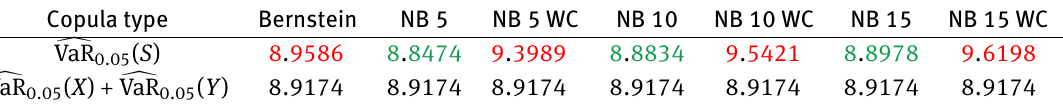
Table 2: Estimates based on Monte Carlo simulations. Bernstein and negative binomial copula approaches Copula type